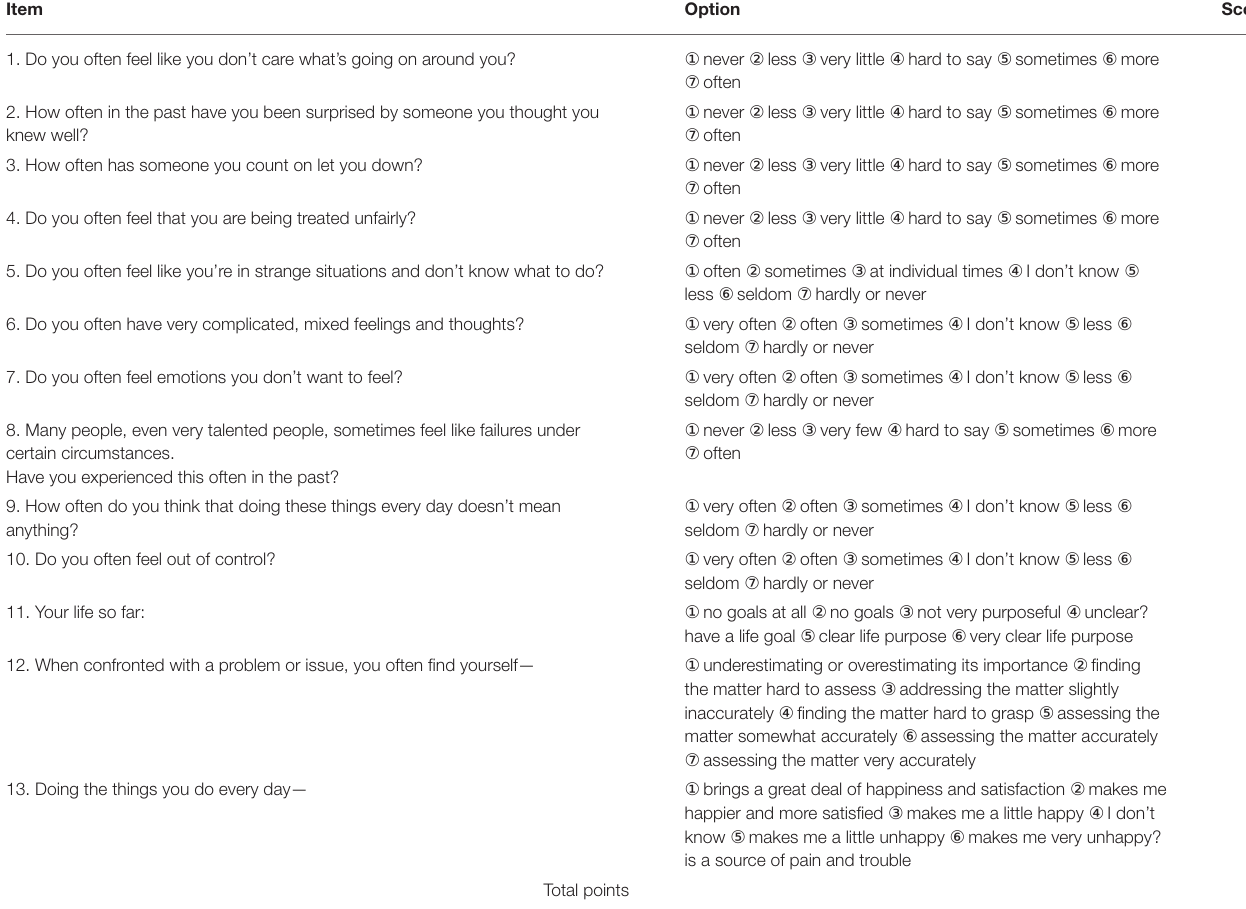
TABLE 1 | Sense of coherence-13, SOC-13.